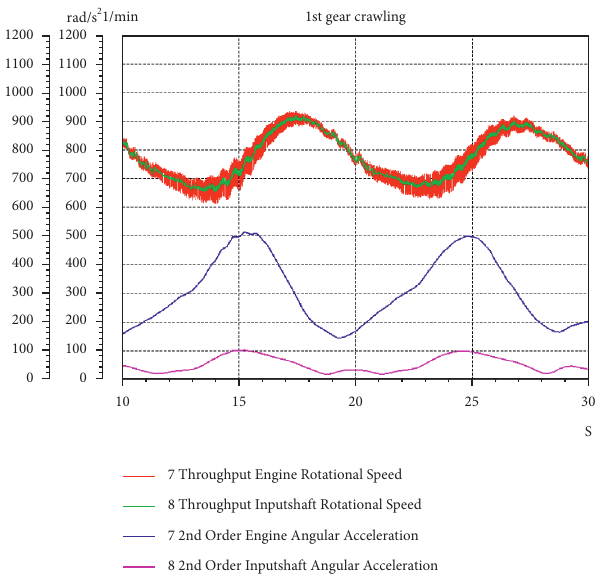
Figure 13: Crawling condition.